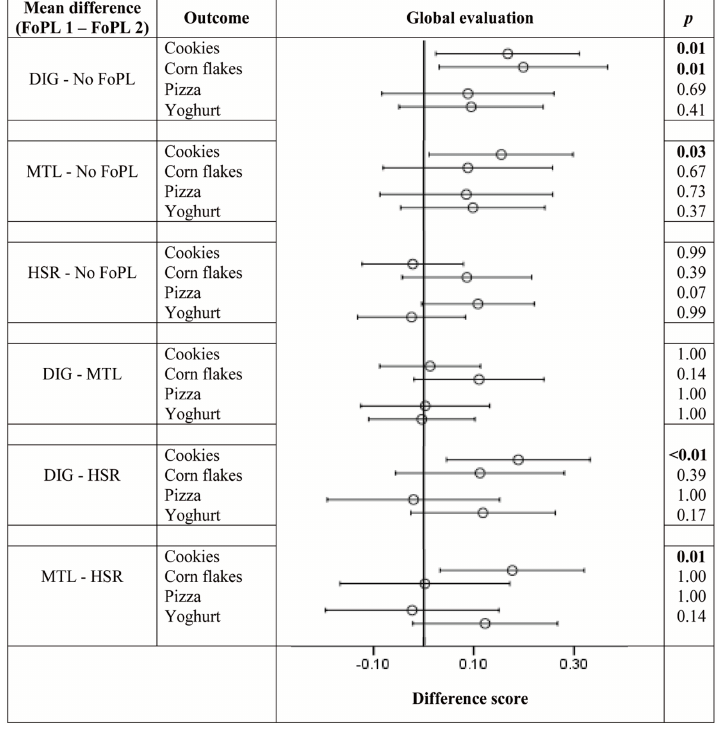
Figure 4. Difference in ratings between FoPLs ( (cid:9) ) and the upper ( (cid:96) ) and lower ( (cid:97) ) bounds of 95% confidence intervals for global evaluations according to food